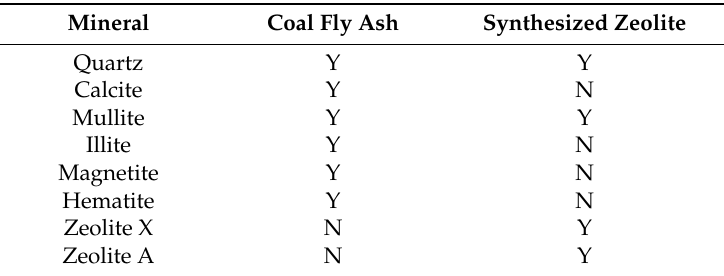
Table 2. Mineralogical phases identified in the coal fly ash and synthesized zeolite. (Y: presence of mineral phase, N: absence of mineral phase).